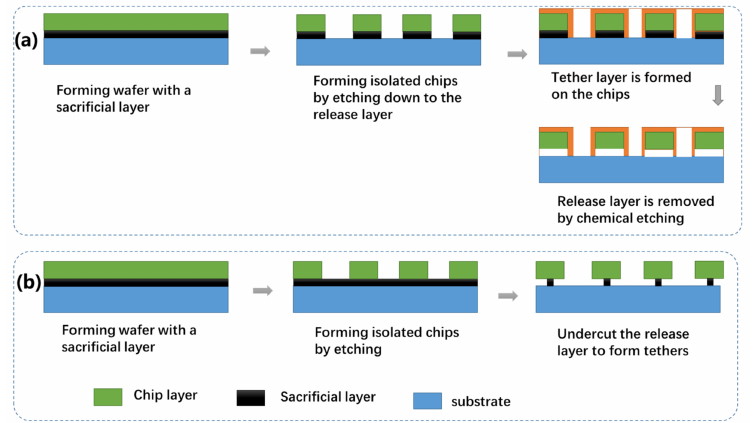
Figure 20. Two methods to form releasable inks with tether structures, where the tether material is introduced externally ( a ), and the tether material is from the epi-layer stack ( b